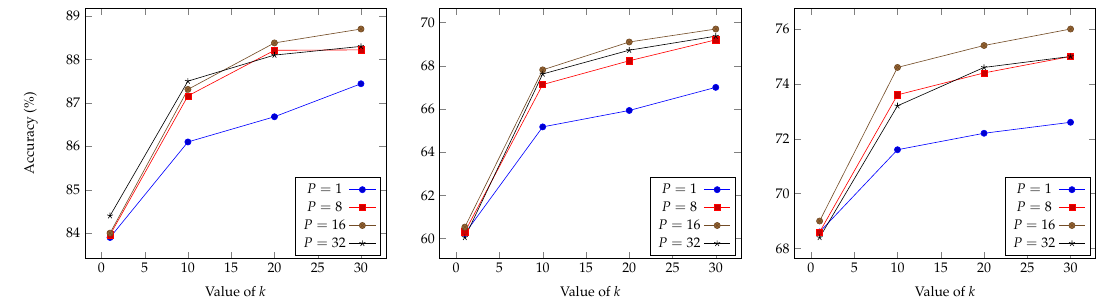
Figure 2. Evolution of the accuracy as a function of P and k for CIFAR10 ( left ), CIFAR100 ( middle ) and ImageNet50 ( right